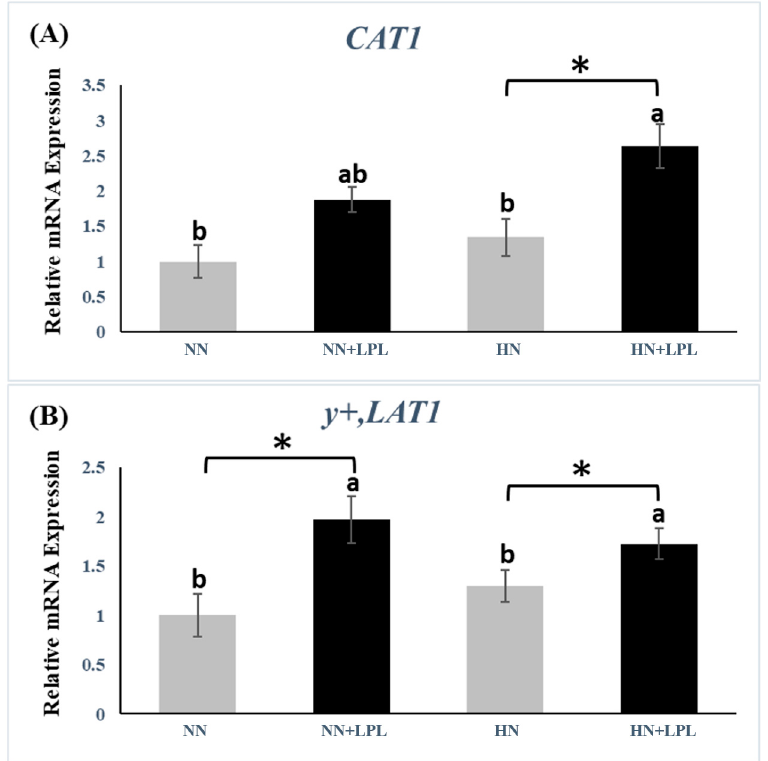
Figure 5. Quantitative gene expression of amino acids transporter in small intestine following LPL supplementation. ( A ) The gene expression of CAT1. ( B ) The gene expression of y+, LAT1. Significant differences between basal diet and diet with LPL supplementation groups are indicated by * p < 0.05. a,b Bars with no common letter differ significantly ( p < 0.05). Error bars indicate the standard error of the mean. CAT1, cationic amino acid transporter 1; y+, LAT1, Y + L amino acid transporter 1. Abbreviation: NN, Normal nutrition diet; NN + LPL, NN + 500 g/t of LPL; HN, NN + 0.5% CP and 50 Kcal/kg; HN + LPL, HN + 500 g/t